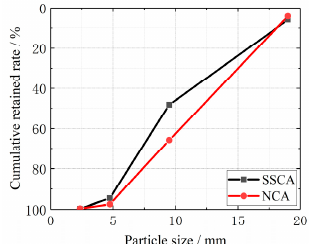
Figure 1. The graining curves for steel slags used as coarse aggregates (SSCA) and natural coarse aggregates (NCA).